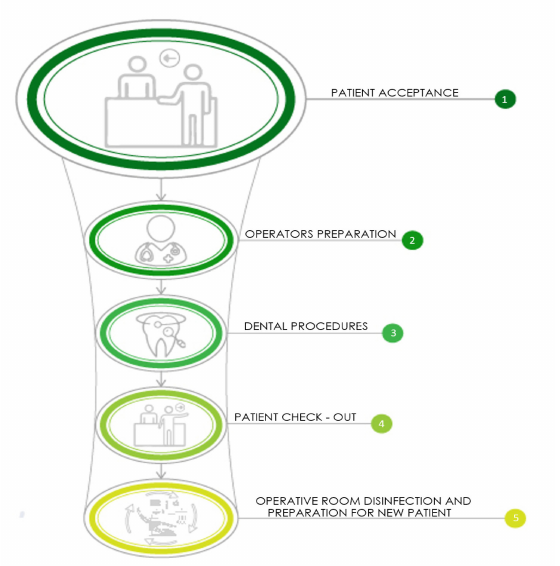
Figure 2. Five operating phases: phase 1, receiving the patient; phase 2, preparing the dental sta ff and patient; phase 3, treatment, phase 4, patient check out; and phase 5, preparing the room for the next